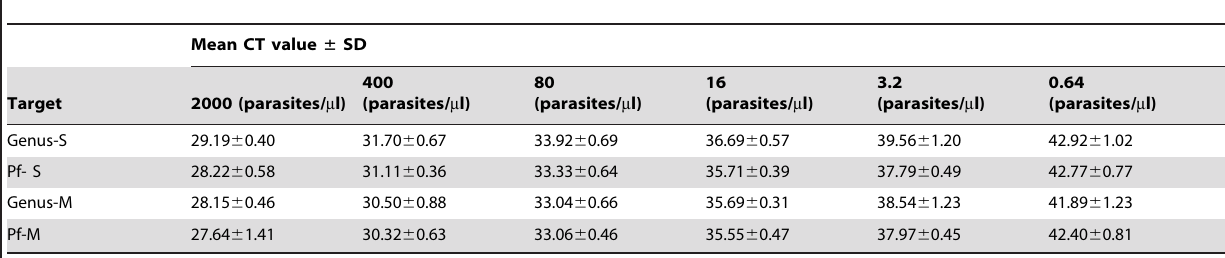
Table 2. Reproducibility of the singleplex and multiplex PET-PCR assays for P. falciparum